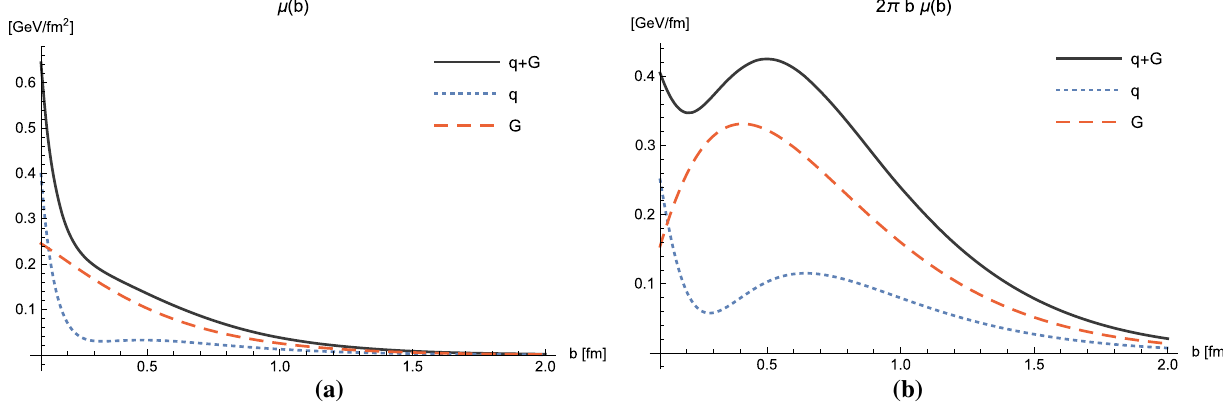
Fig. 18 Plots of the two-dimensional Galilean energy density, a μ( b ) and b 2 π b μ( b ) , using the multipole model (11) with parameters given